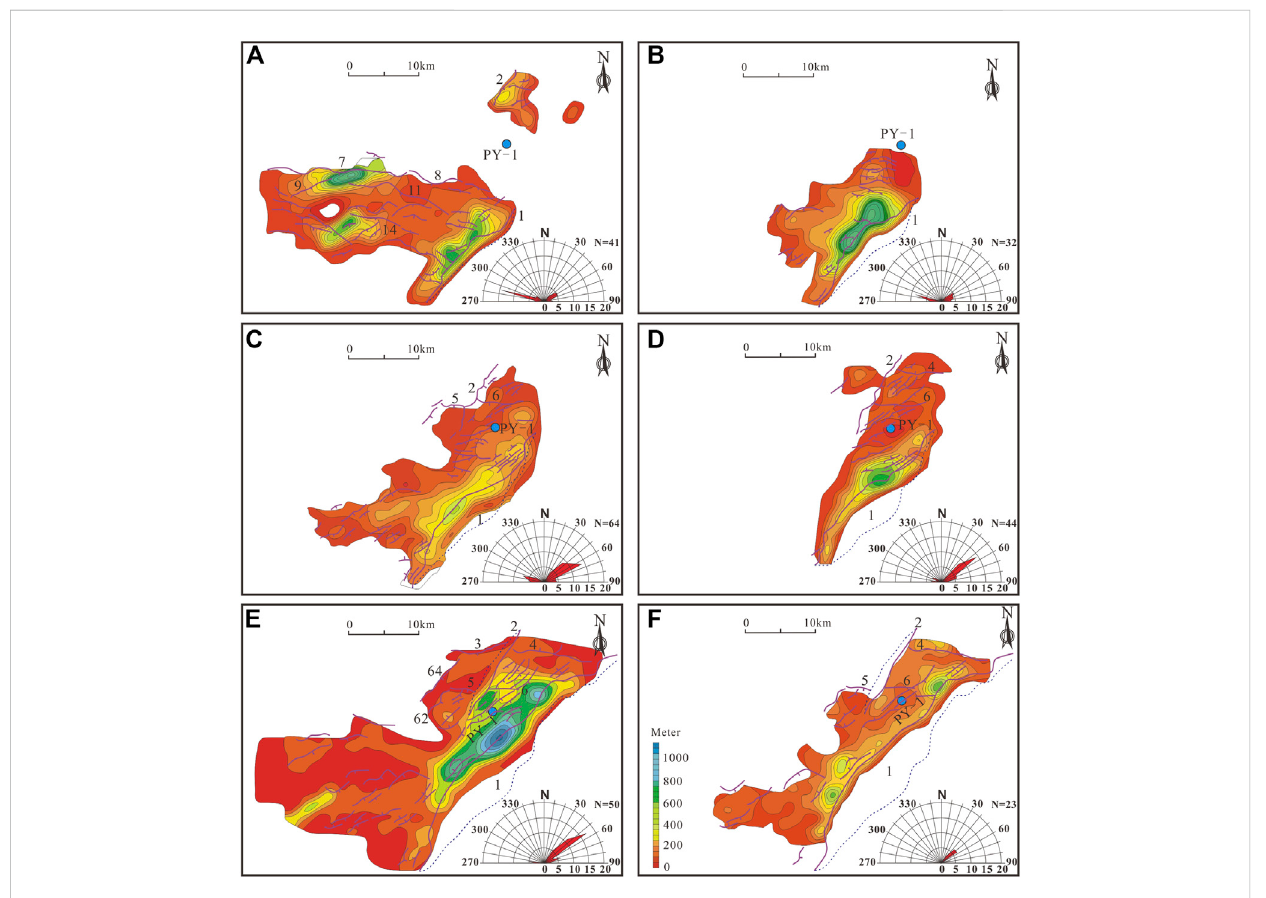
FIGURE 7 The comparison of syn-sedimentary faults, strike rose diagram of faults and sedimentary thickness distribution from Member 1 to Member 6 [from (A – F) ] of Wenchang